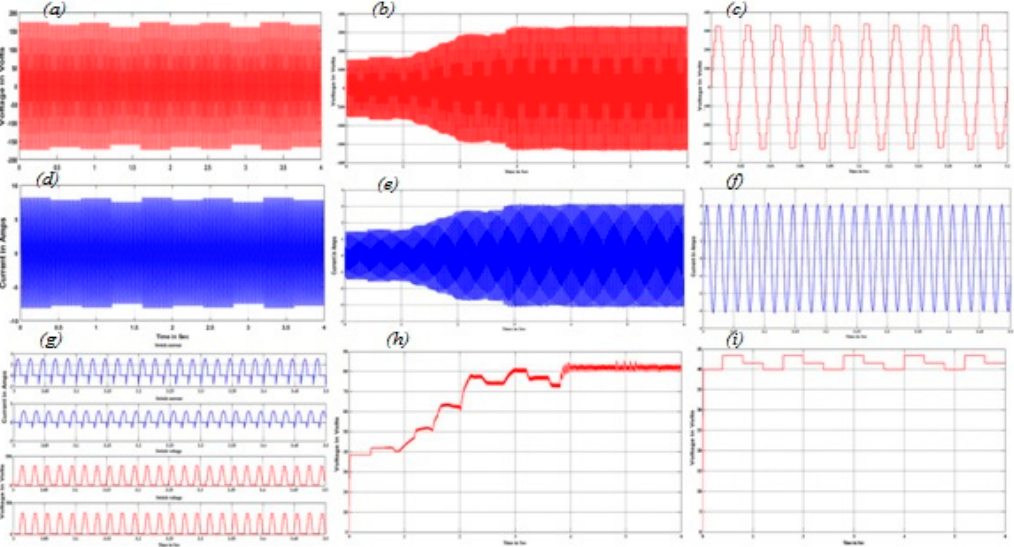
Figure 10. Multilevel inverter voltage waveform ( a ) without voltage balancing circuit; ( b ) with voltage balancing circuit; ( c ) steady-state voltage, multilevel inverter current waveform and ( d ) without voltage balancing circuit; ( e ) with voltage balancing circuit; ( f ) steady-state current; ( g ) current and voltage across the H-bridge switches; ( h ) output voltage and ( i ) variation in irradiance.